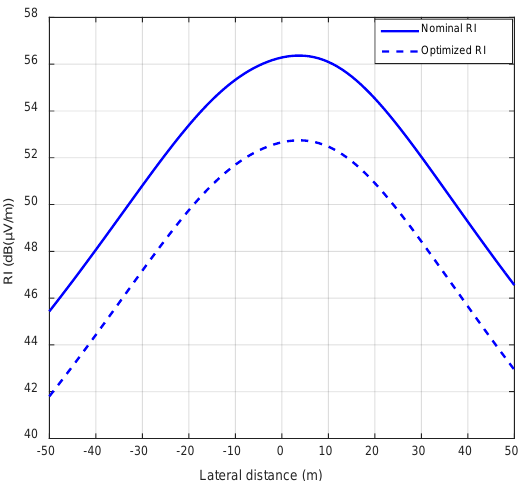
Figure 10. Comparison of nominal and optimized RI lateral profiles for ± 500 kV line. Table 6. Optimal geometric parameters for ±600 kV HVDC line.